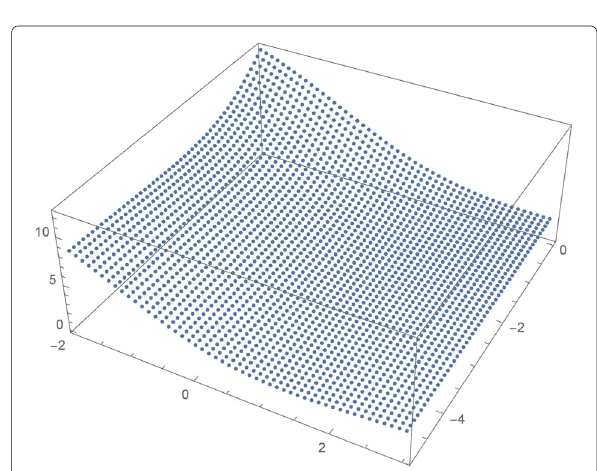
Fig. 14 Variance of the procurement cost V [ C ]